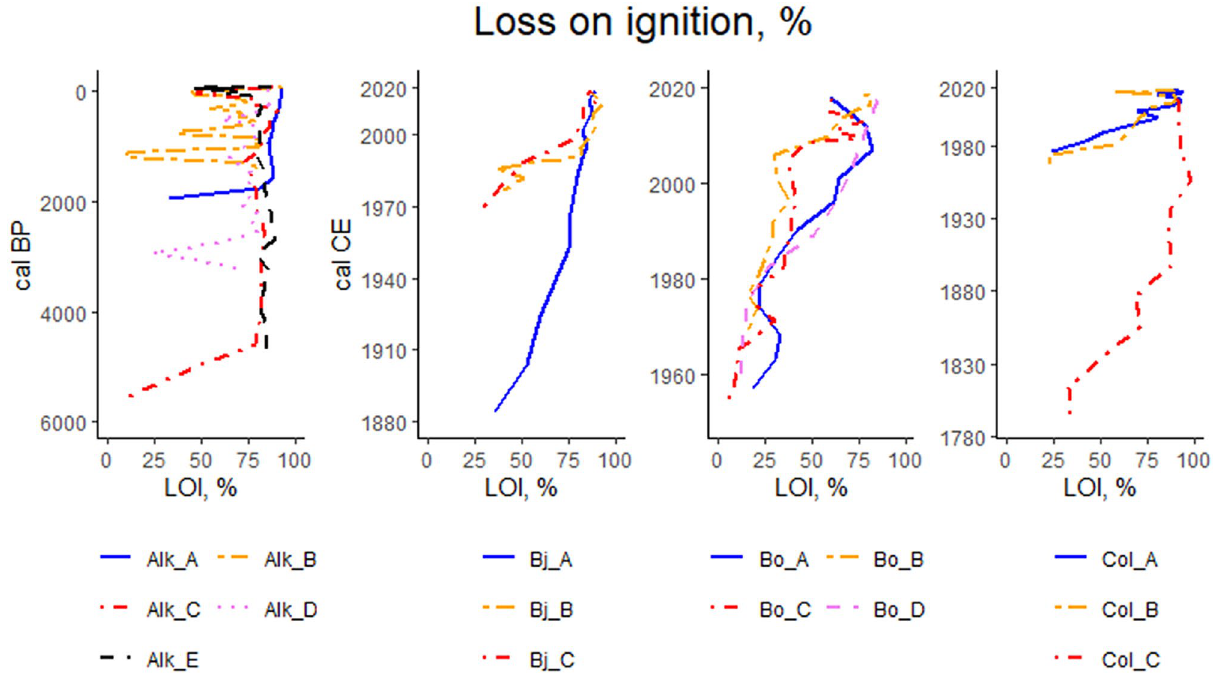
Figure 7. Loss on ignition (%) at different soil layers. Each panel represent different study site. For the study site Alkhornet (Alk), age is presented as calibrated Before Present (cal BP) while for Bjørndalen (Bj), Bolterdalen (Bo) and Colesdalen (Col) ages are presented as calibrated Common Era (cal CE).